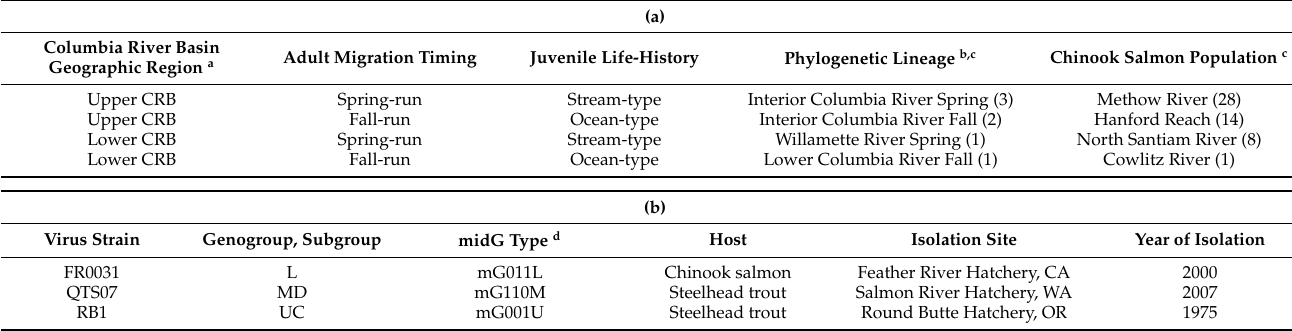
Table 1. Fish and virus strains, used for controlled experimental studies. ( a ) Columbia River Basin (CRB) Chinook Salmon ( Oncorhynchus tshawytscha ) Populations. ( b ) Infectious Hematopoietic Necrosis Virus (IHNV) Strains.